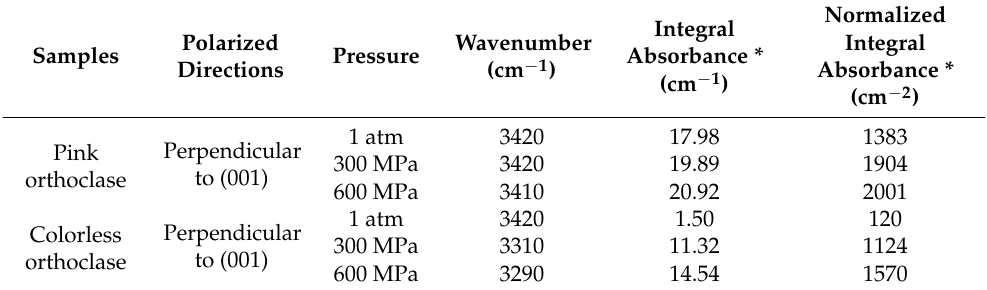
Table 3. FTIR spectra and analysis of two types of orthoclase at 300 and 600 MPa